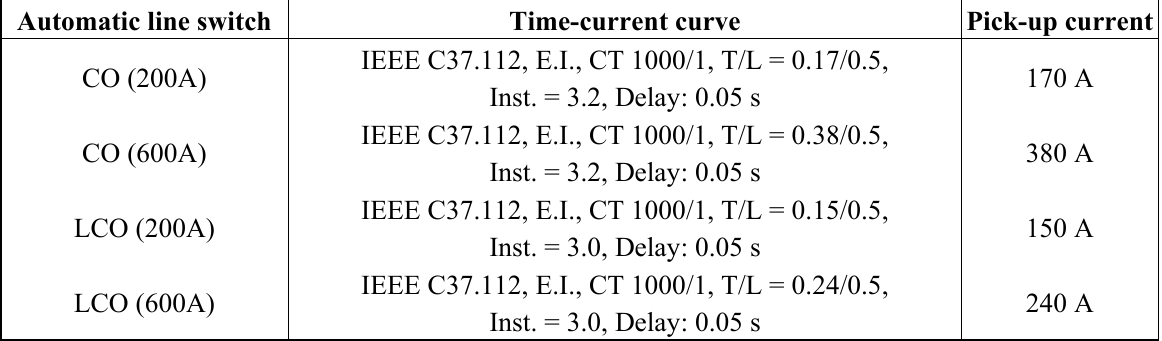
Table 3. Proposed automatic line switch CO and LCO relays characteristic curve parameters.